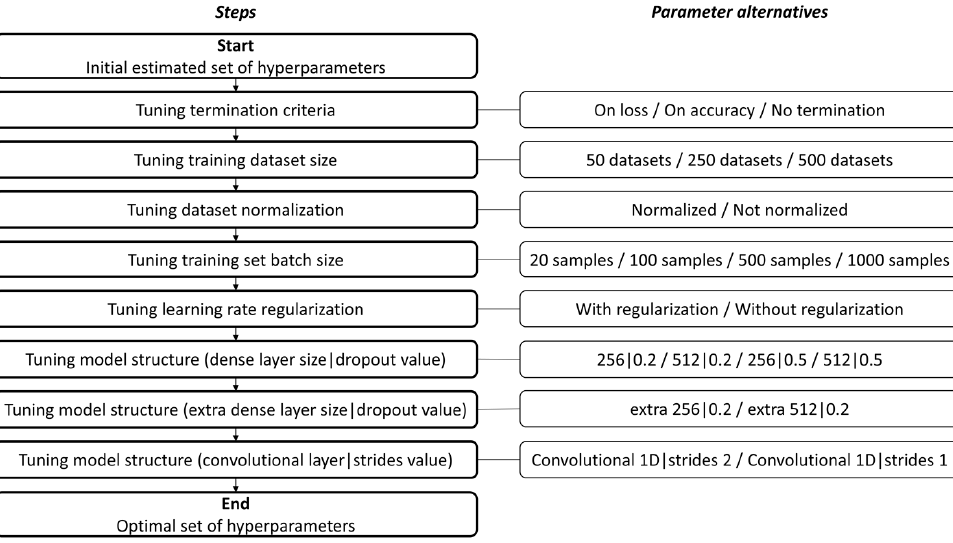
Figure 4. Sequence of steps to determine the optimal set of hyperparameters, including the tuning of training termination criteria, dataset size, dataset normalization, training set batch size, learning rate regularization and model structure (dense layer size and dropout layer value, adding an extra dense layer, and adding a convolutional layer with a specific strides value).